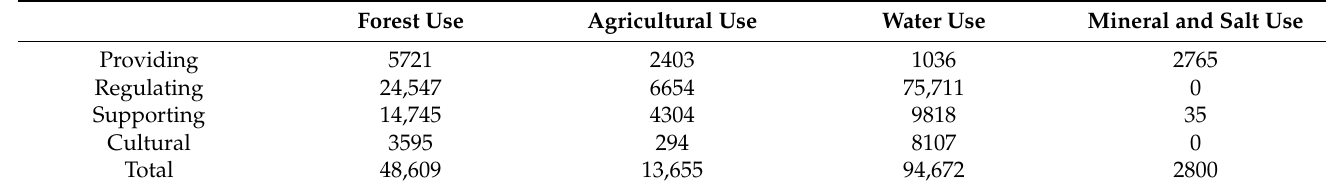
Table 1. Ecosystem service value provided by various types of land use. Forest Use Agricultural Use Water Use Mineral and Salt